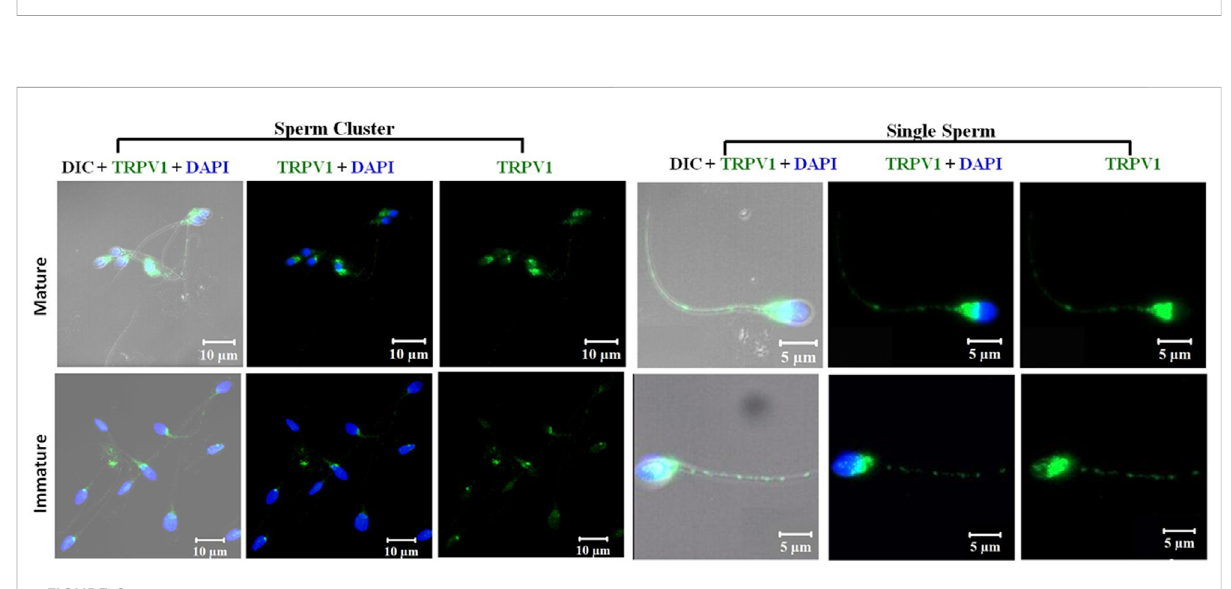
Most acrosomal reaction-inducing agents (progesterone, RTX, and H 2 O 2 ) caused an elevation of [Ca 2+ ]i. Progesterone treatment resulted in the highest [Ca 2+ ]i followed by H 2 O 2 and then RTX. On the other hand, H 2 O 2 +RTX treatment showed